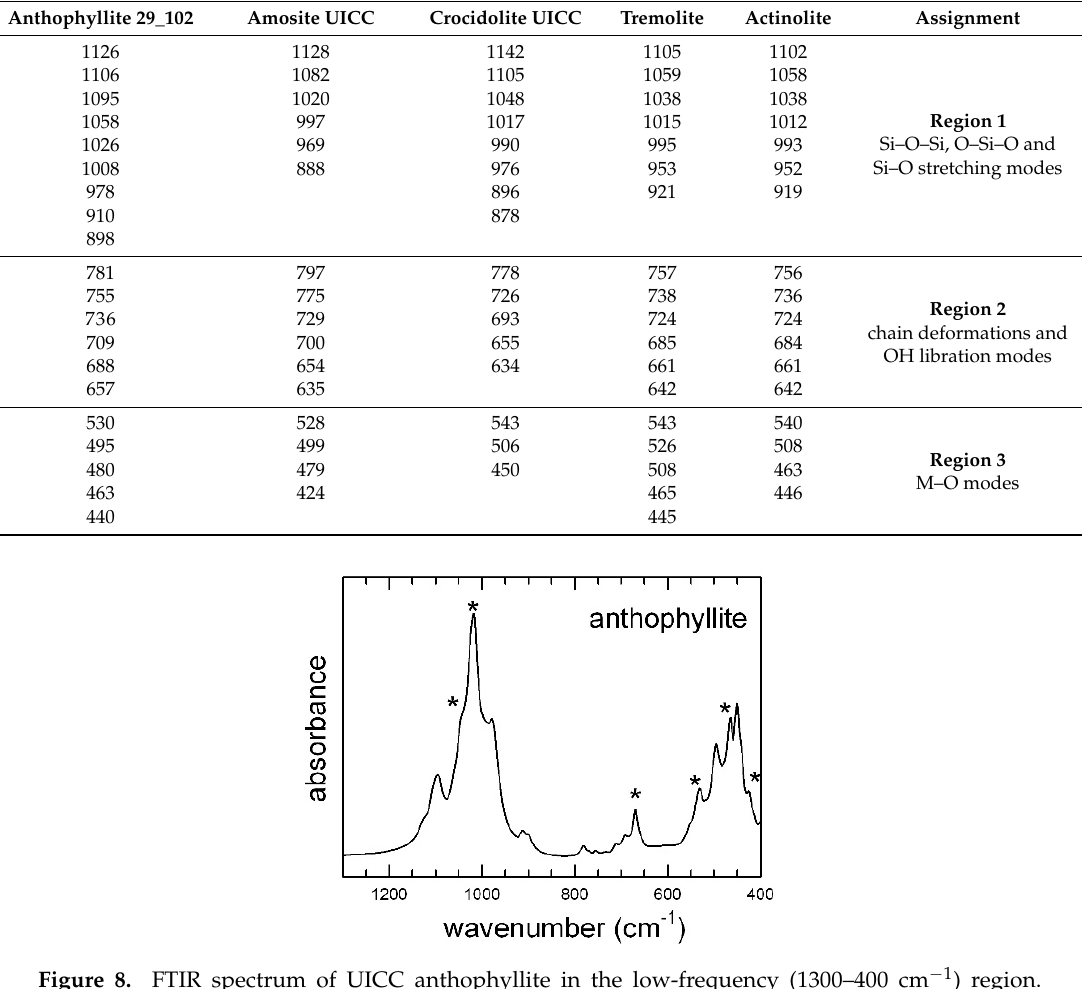
Table 4. Peak positions (cm -1 ) and band assignment (according to 71) for the studied amphiboles in the low-wavenumber (<1200 cm -1 ) range.